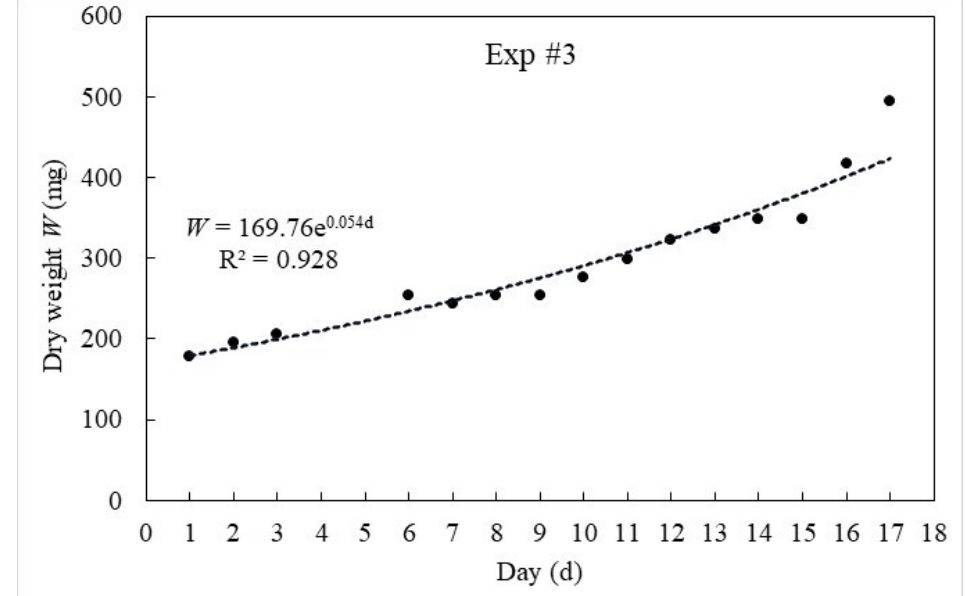
Figure 3. Aurelia aurita . Increase in dry weight of jellyfish fed 100 Artemia l − 1 . The b -exponent of the exponential regression equations shows that the mean weight-specific growth rate is 5.4% d − 1 .